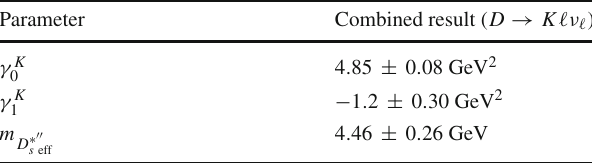
Table 277 Results of the three-pole model form factors obtained from a fit to all measurements. Fitted parameters are the first two residues γ K 0 and γ K , which are constrained using present measurements of masses 1 andwidthsofthe D ∗ s and D ∗ mesons,andlatticecomputationsofdecay s 1 constants, and the effective mass, m , accounting for higher mass D ∗(cid:7)(cid:7) s eff hadronic contributions